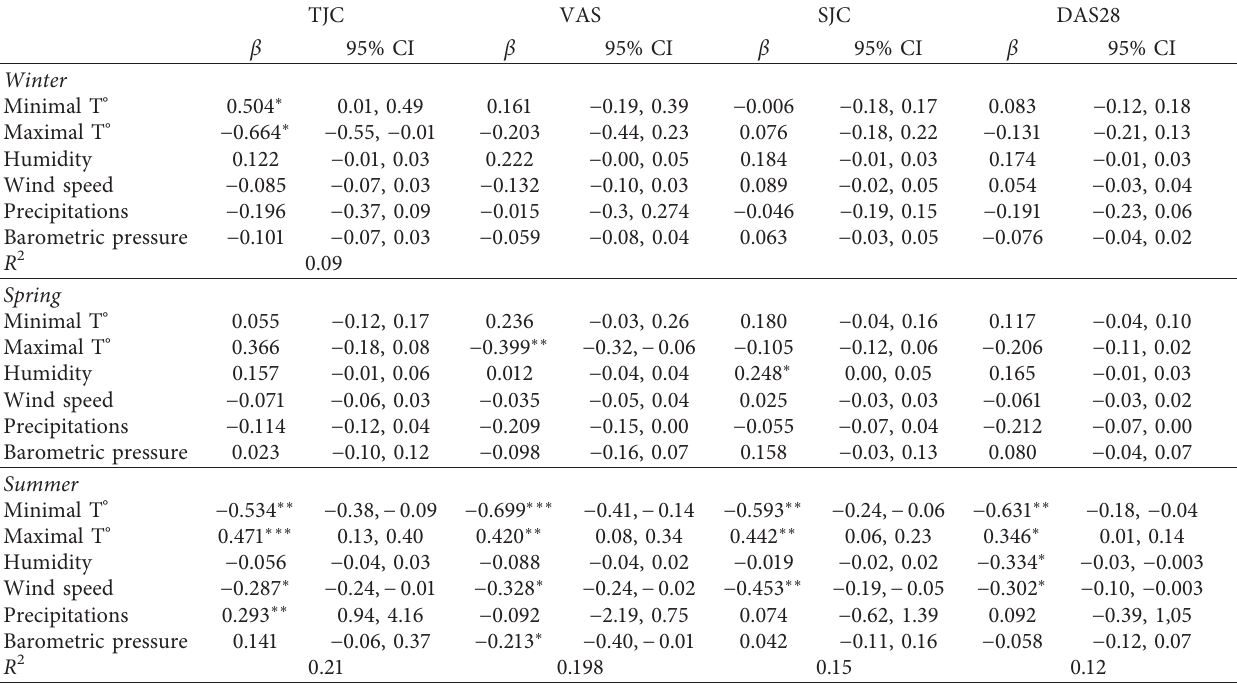
Table 4: Multiple linear regression